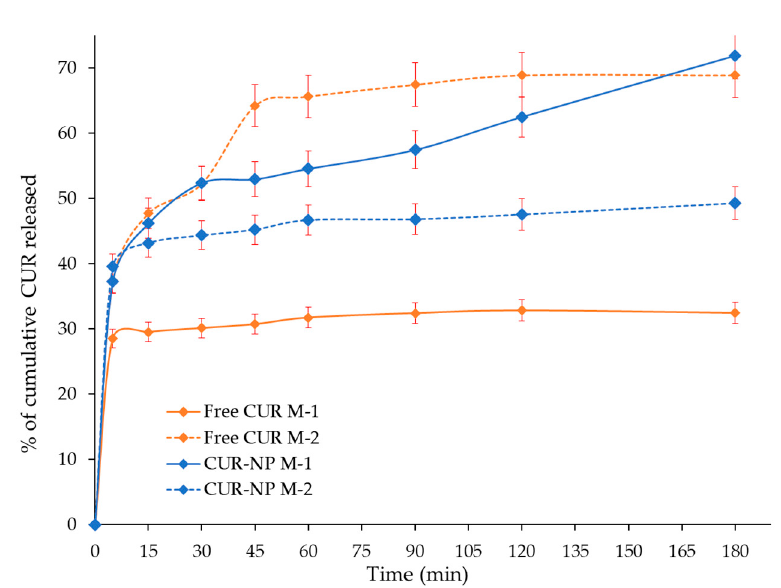
Figure 5. Release profile of CUR from the NP compared to free CUR dissolution rate in two dissolution media. Error bars represent the standard deviation of CUR concentration in the triplicates.